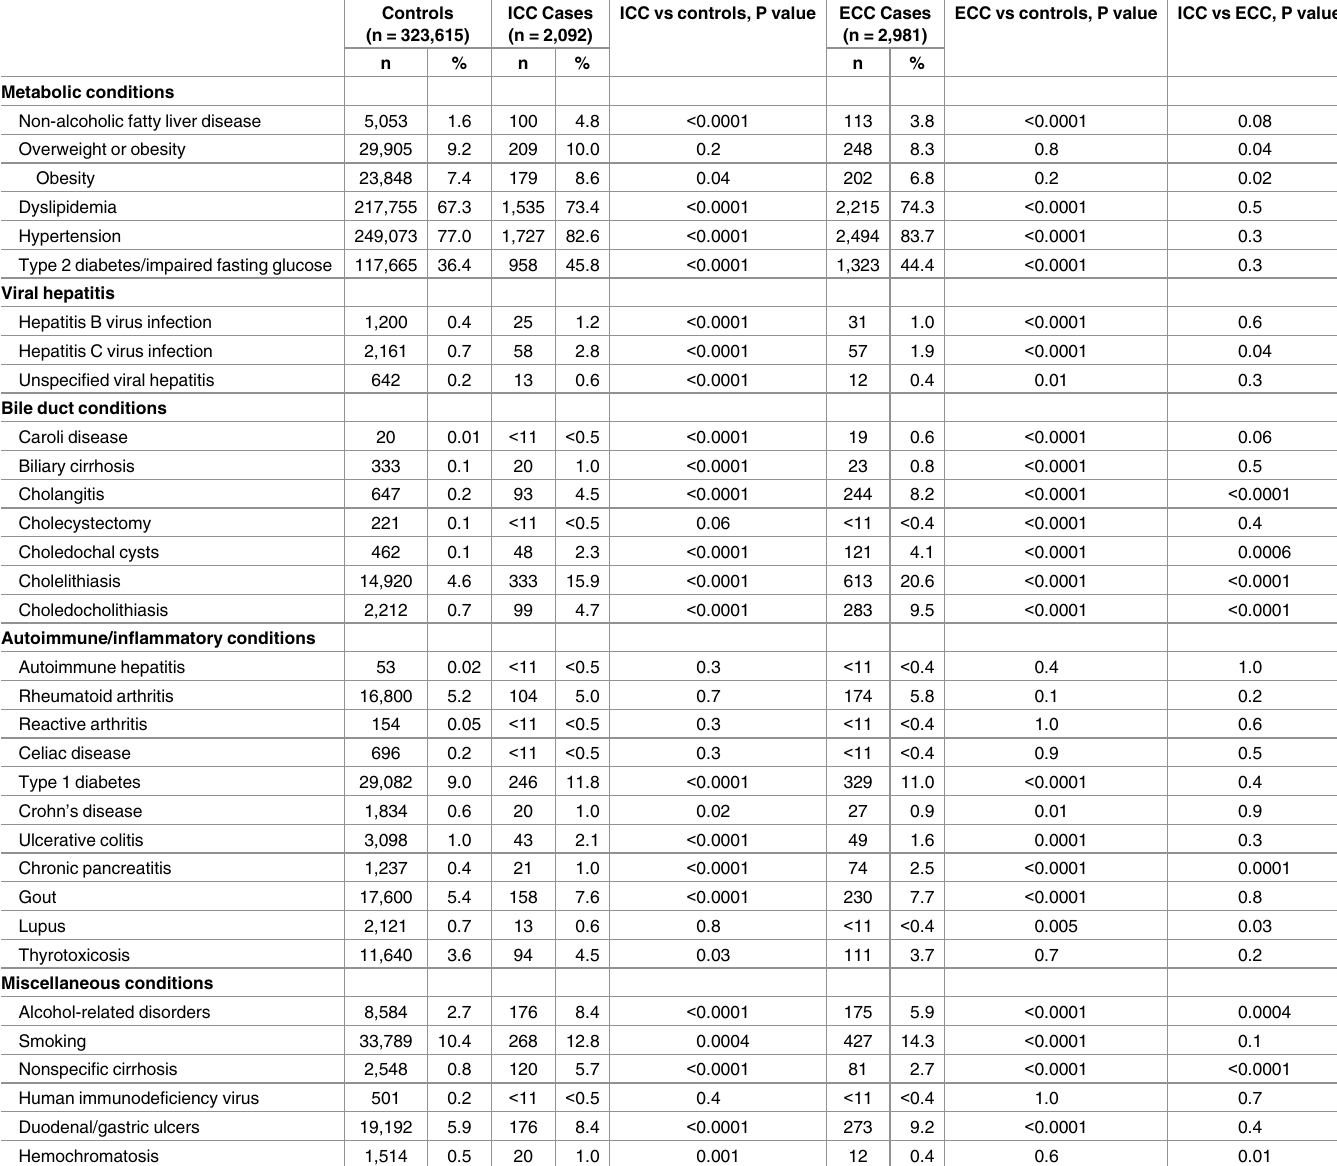
Table 3. Comparison of preexisting medical conditions among ICC cases,ECC cases, and controls, SEER-Medicare 2000–2011 1